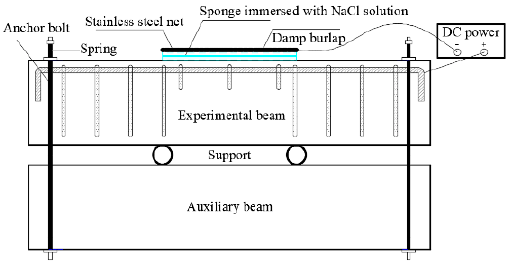
Figure 6. Coupled load–corrosion test. Figure 5. Electro-osmosis test.